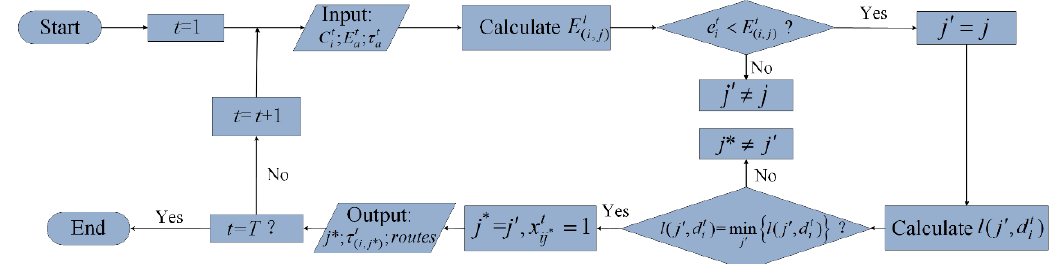
Figure 4. Flowchart of the shortest driving distance (SDD) strategy.